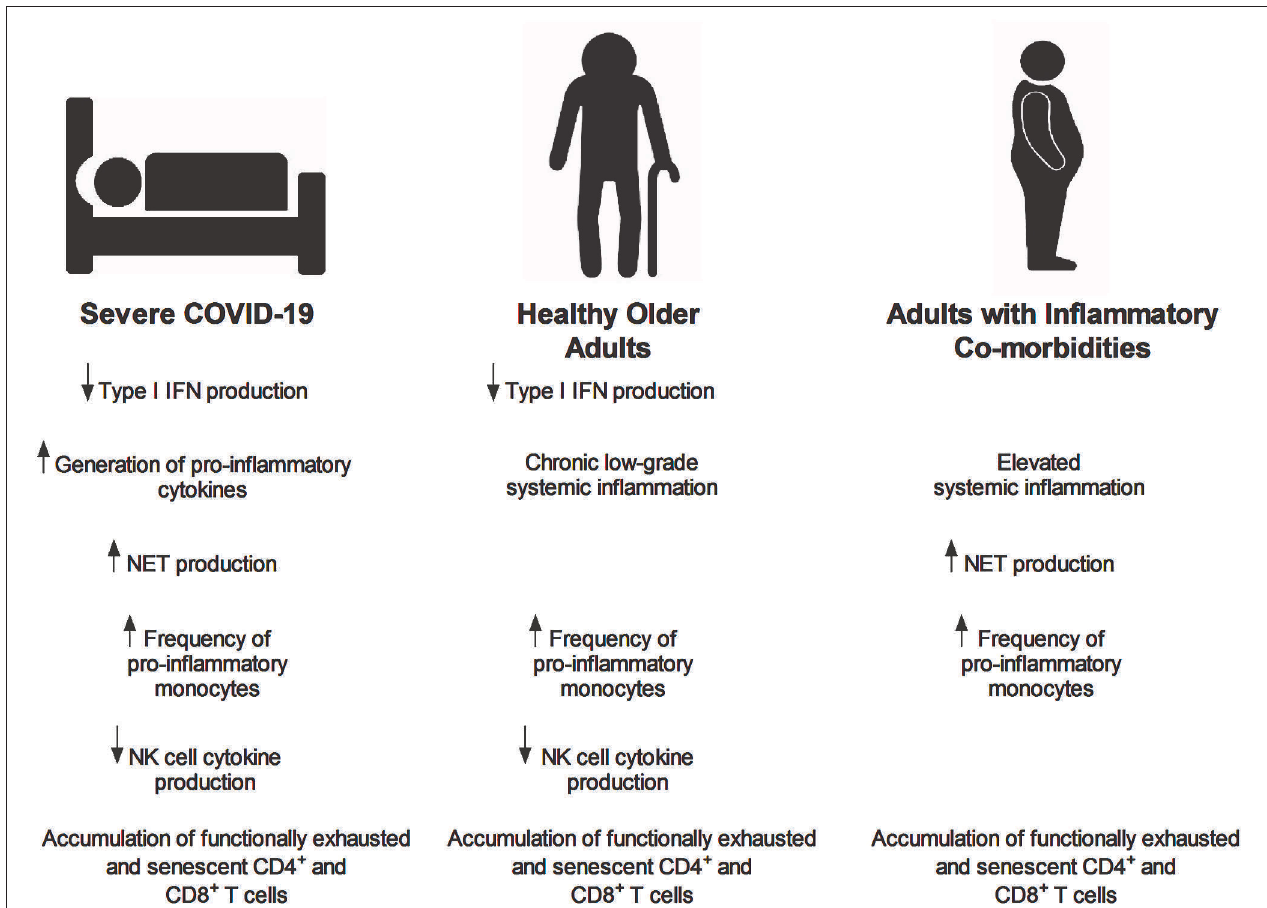
FIGURE 1 | Immunesenescence: a risk factor for severe COVID-19? Similarities between the immune profile of patients with severe COVID-19, healthy older adults and adults with inflammatory co-morbidities (obesity and type 2 diabetes). IFN, Interferon; NET, Neutrophil extracellular traps; NK, Natural killer.